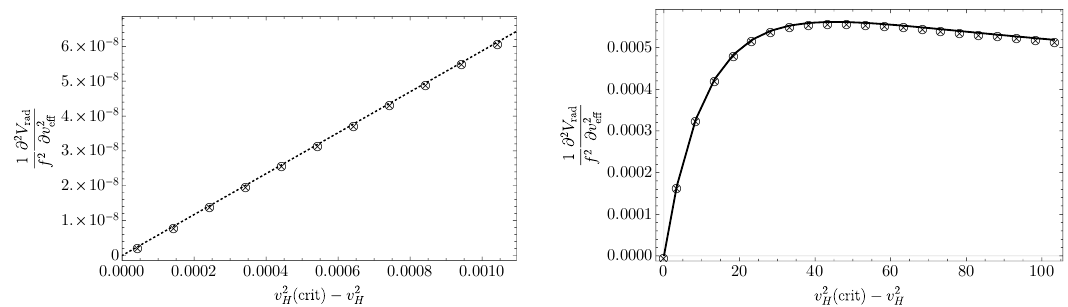
Figure 8. In this (cid:12)gure, we display the curvature of the radion potential as a function of the e(cid:11)ective Higgs VEV for v 2 < v 2 (crit). In the plot on the left, we focus on v 2 H H value, while on the right, we display the curvature for a wider range of v 2 critical v 2 , the behavior is well described by a line intersecting with the origin, with the critical value H here determined to be v 2 (crit) = (cid:0) 16 : 58305645, apparently consistent with the value determined H on the sub-critical side in (cid:12)gure 7 up to numerical errors in the solving routine. While the radion potential has a smooth minimum (as a function of the e(cid:11)ective Higgs VEV) in this dynamical model on either side of the critical value of v 2